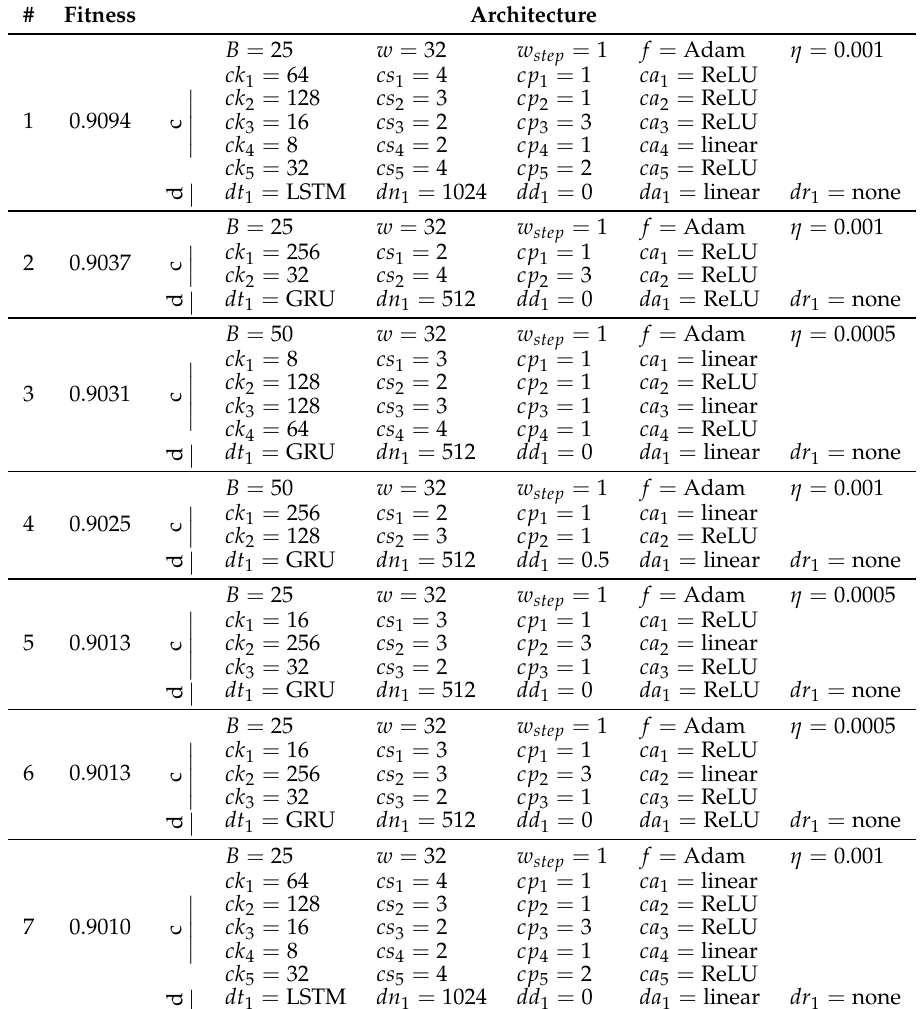
Table 5. Architecture and fitness of the top seven individuals in the hall-of-fame for GE in the OPPORTUNITY Gestures dataset. GRU: gated recurrent unit; LSTM: long short-term memory; ReLU: rectified linear